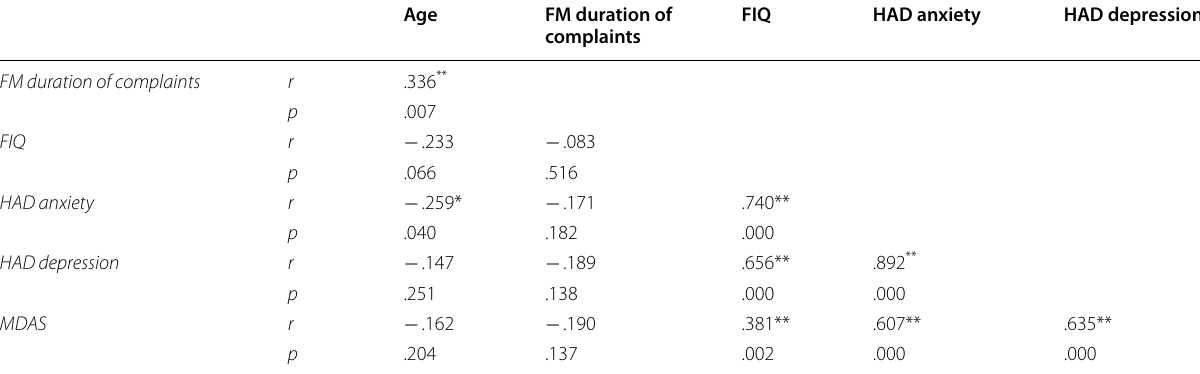
r, Spearman correlation coefficient; p, p value; **Significance level p < 0.01; *Significance level p < 0.05; FM, fibromyalgia syndrome; FIQ, fibromyalgia impact questionnaire; HAD, hospital anxiety and depression scale; MDAS, modified dental anxiety